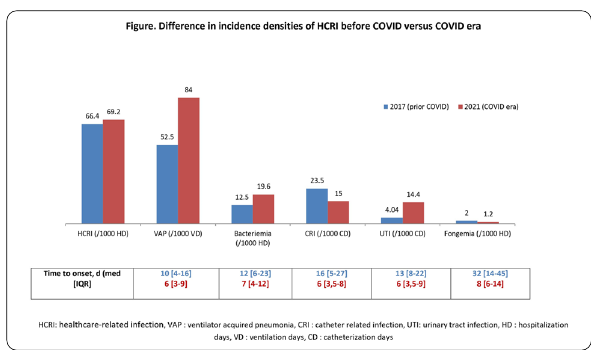
Figure. Difference in incidence densities of HCRI before COVID versus COVID